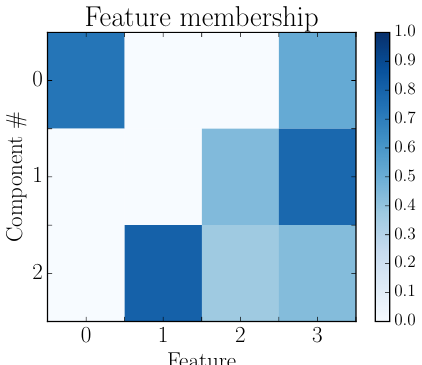
Figure 2. Feature membership in the components: we show the matrix B in which we zero-out the entries which are not included in the 95% of the norm of the component. Here, the colorbar indicates the level of membership of each feature to the three different components. The features are respectively: assists (0), deaths (1), kills (2), and gold